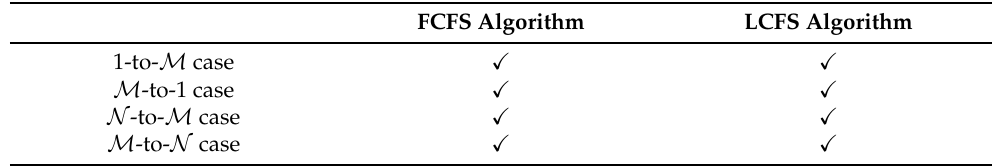
Table 5. Eight Monte Carlo simulation